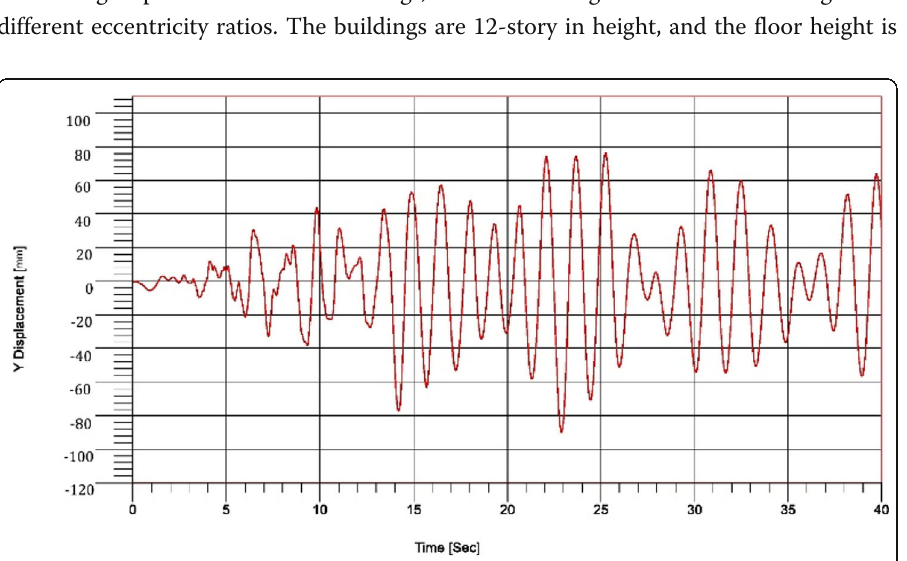
Fig. 20 Top roof displacement time history (yield